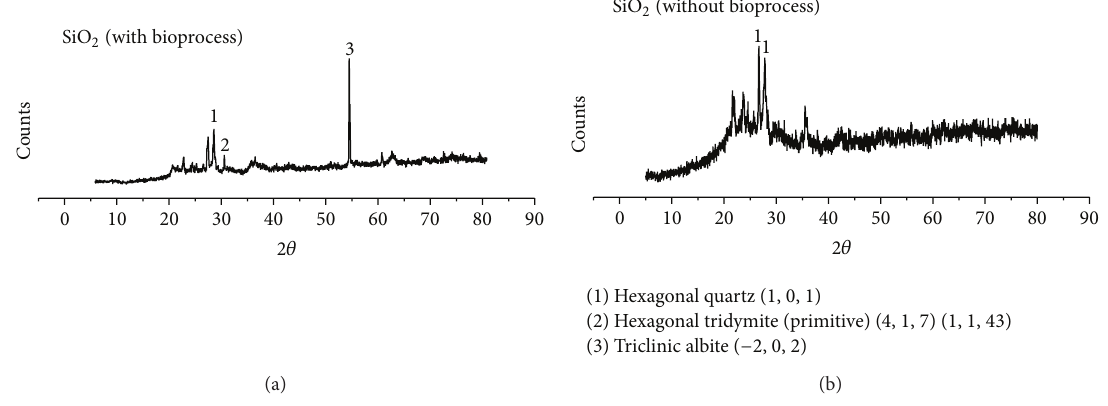
Figure 4: X-ray diffraction of silica particles obtained for annelids bioprocess (a) and without bioprocess (b). Table 1: EDS to silica particles synthesized without bioprocess and with